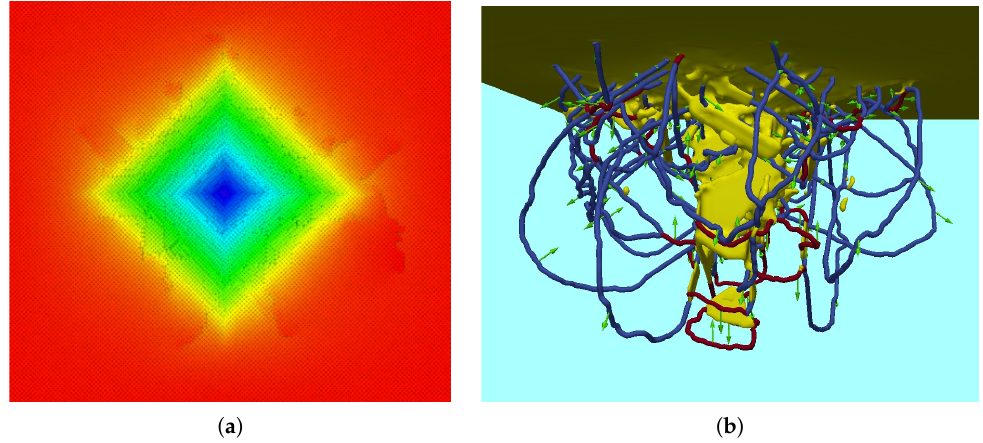
Figure 4. Indentation with a Vickers indenter into an Fe (100) surface. ( a ) Indent pit. ( b ) Dislocation network. Original contribution of the